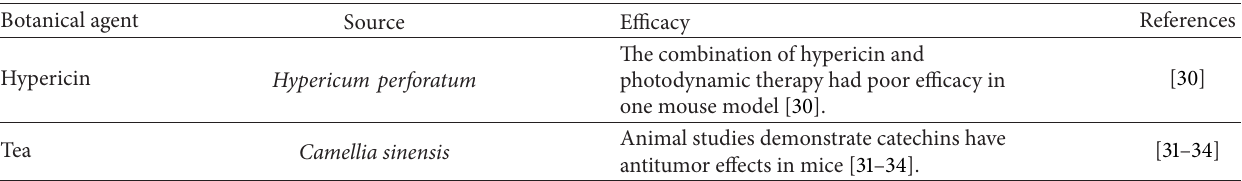
Table 2: Summary of the effects of botanical agents studied in mice that have also been studied in humans. Botanical agent Source Efficacy